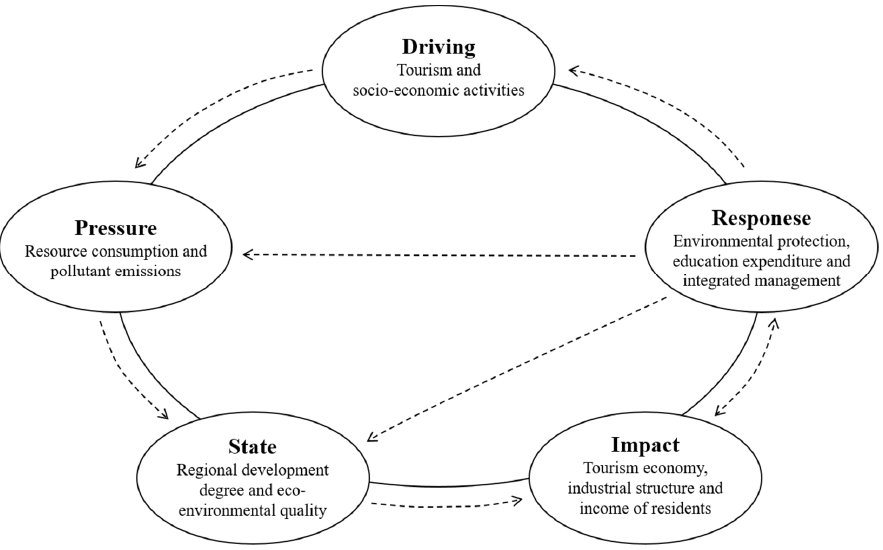
Figure 3. The operational mechanism of the DPSIR model.